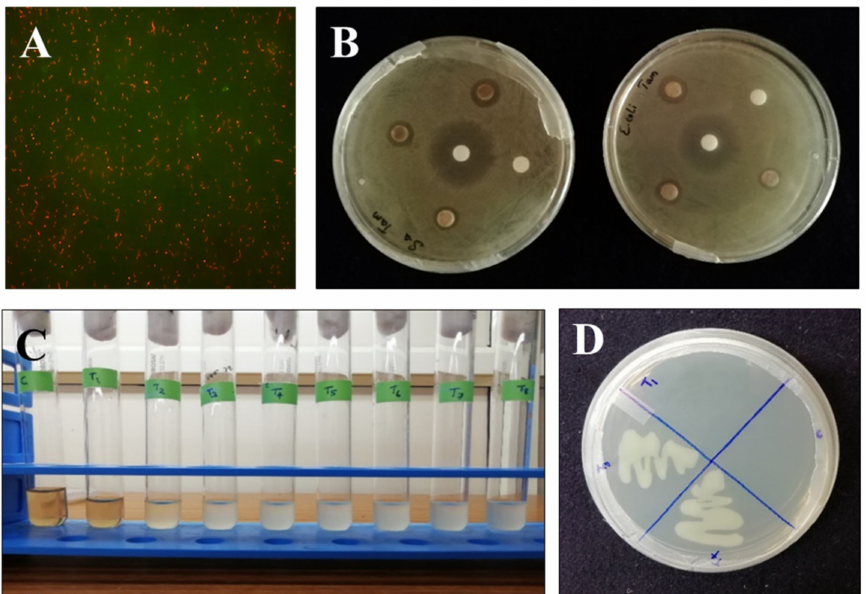
Figure 5. ( A ) Antimicrobial activity of AgNPs against Escherichia coli using fluorescent microscopy. ( B ) Antibacterial activity of different concentrations (5, 10, and 20 µ g/ µ L) of AgNPs against Staphylo- coccus aureus and Escherichia coli using the disc diffusion method. ( C ) Determination of minimum inhibitory concentration (150 µ g/mL) of AgNPs showing antibacterial activity. ( D ) The minimum bactericidal concentration of